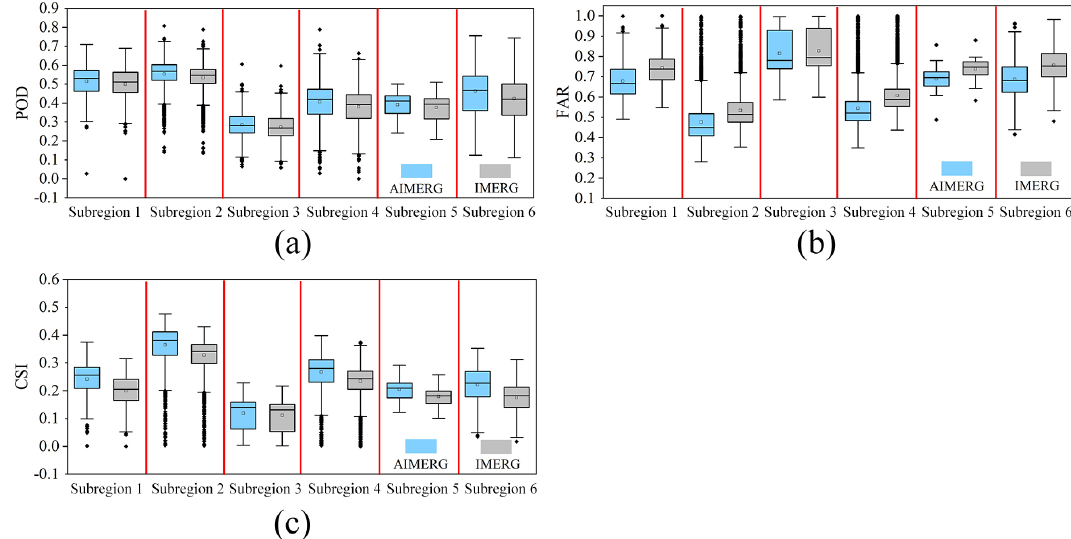
Figure 8. The boxplots demonstrate results of the precipitation events by IMERG and AIMERG against the ground observations from the meteorological stations at an hourly scale in six subregions in 2015.